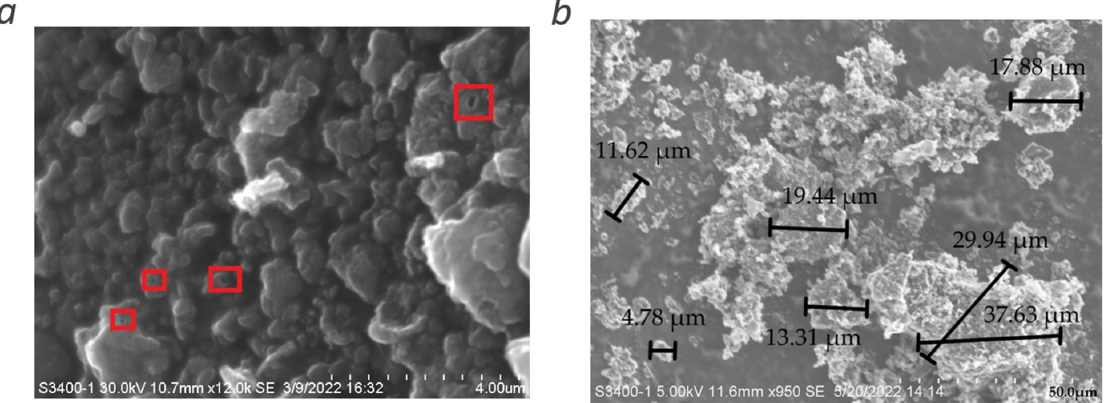
Figure 6. SEM images of ( a ) the surface and ( b ) the flake of the synthesized multilayer graphene